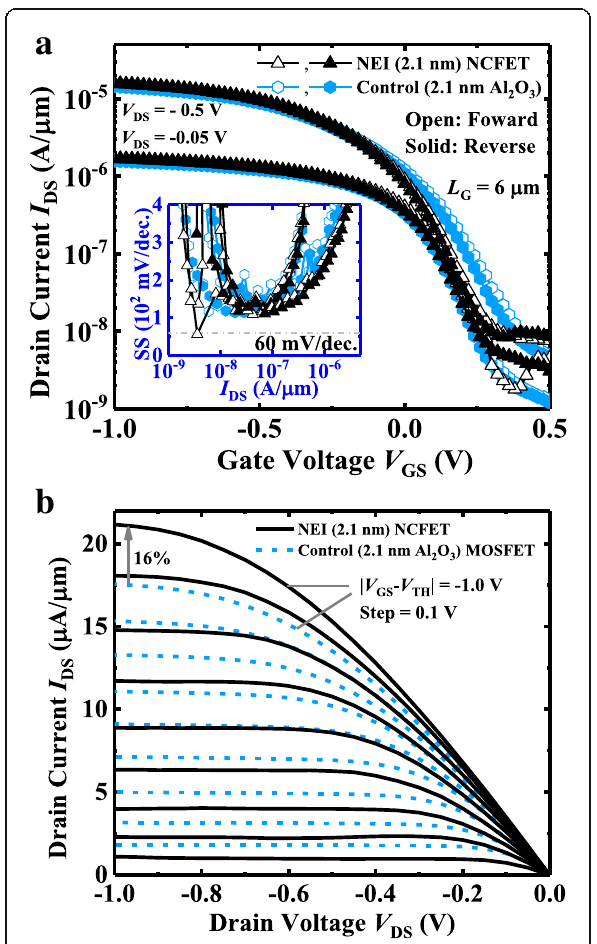
Fig. 8 a I DS - V GS curves of an NEI NCFET and control MOSFET with pure Al 2 O 3 dielectric. Both devices have the 2.1-nm gate insulator. The inset shows that the NCFET has steeper SS than control device up to the threshold voltage. b Measured I DS - V DS curves for NCFET and control MOSFET. NDR is observed for NCFET at very low V GS . At ∣ V GS − V TH ∣ = ∣ V DS ∣ = 1.0 V, NCFET achieves a 16% I DS improvement compared to the control device